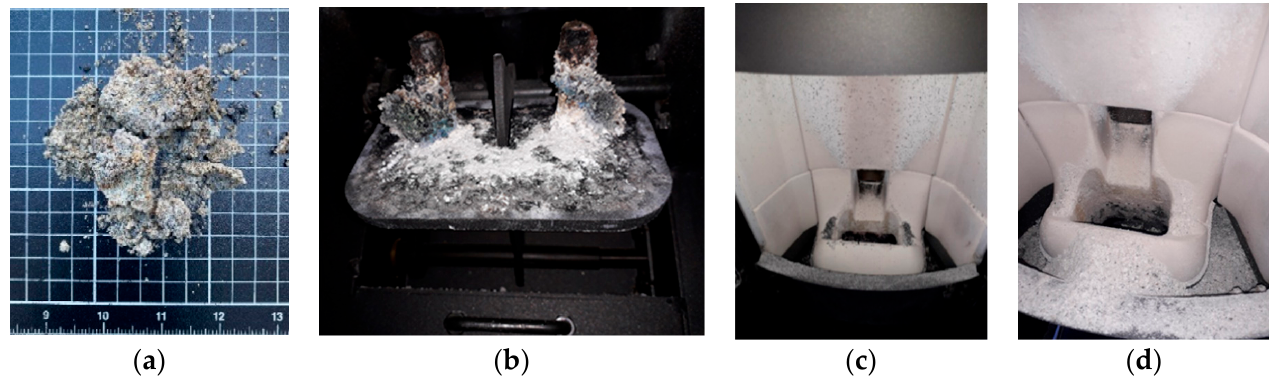
Figure 3. Photographs of ( a ) grate ash from non-additivized corn cob pellet combustion (CCP); ( b ) hinged-grate after non-additivized corn cob pellet combustion (CCP); ( c ) combustion chamber after experiment with non-additivized corn cob pellets (CCP); ( d ) combustion chamber after combustion with 1.5 wt. % kaolin (CCPB0.5KAO).